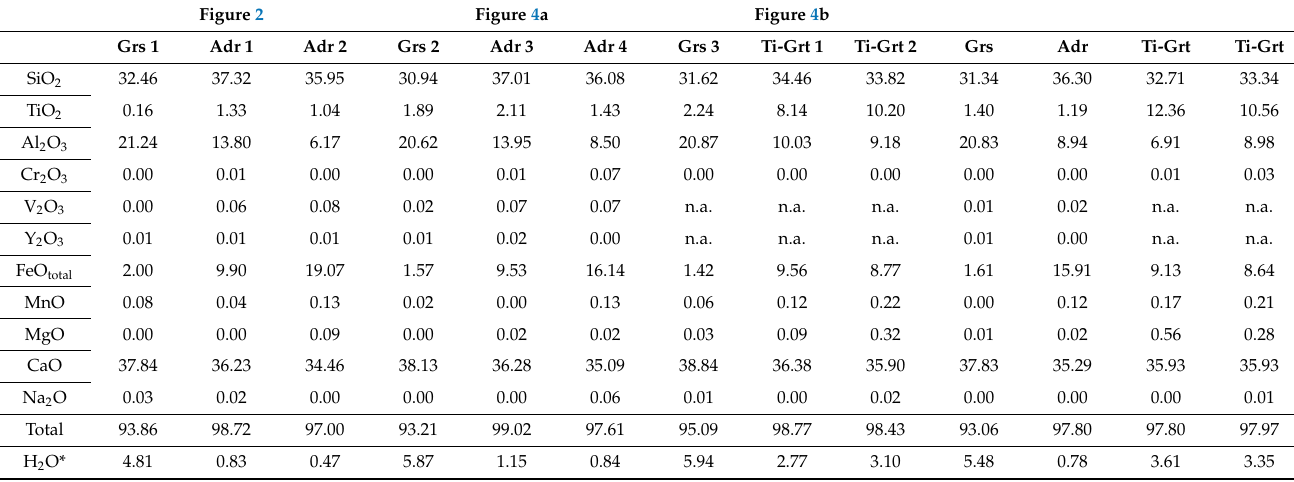
Figure 2. Microphotographs of rodingite samples from Dobšin á ; ( a ) Heterogenous garnet solid solution, plane polarized light. ( b ) Main mineral assemblage consisting of clinopyroxene relics, heterogenous garnet matrix and well-crystallized colorless crystals of vesuvianite, plane polarized light. Ves—vesuvianite; Grt—garnet; Cpx—clinopyroxene. Table 1. Representative electron-microprobe composition (wt%) of garnet solid solution from Dobšin á